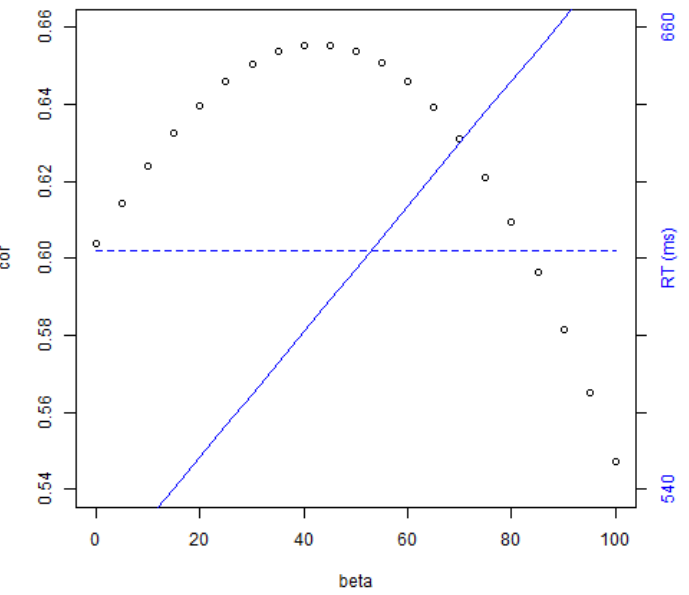
Figure A3. DIANA’s simulations for a word identification task. The dataset is a morphologically homogeneous subset of BALDEY. The black dotted curve shows the correlation between DIANA’s RTs and the average RT of participants as a function of beta ( β ), the coefficient of the entropy in the equation for DIANA’s RT. The solid blue line shows the average of DIANA’s RT as a function of β , while the dashed blue horizontal line indicates the participant’s mean RT. The right-hand side vertical axis pertains to the blue